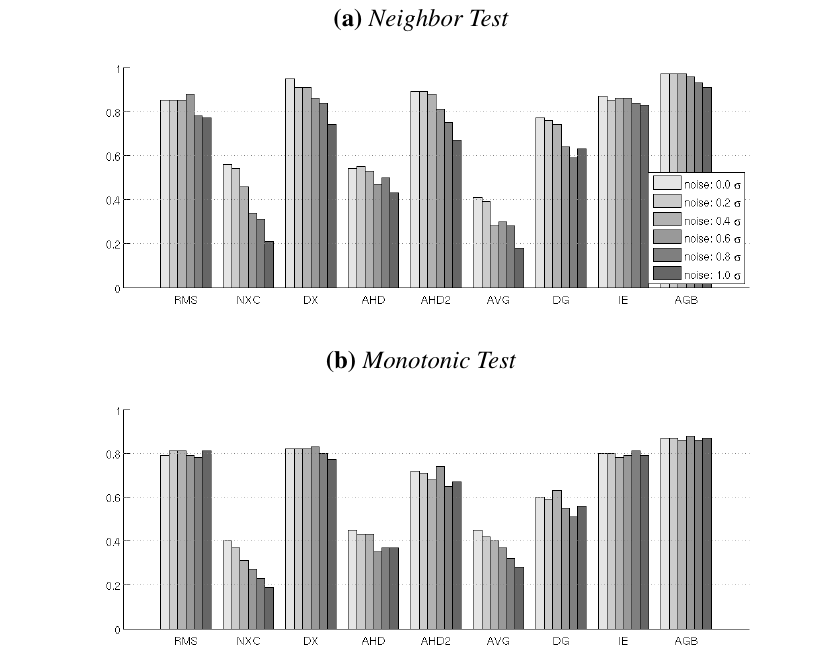
Figure 7. Fraction of Passed Neighbor Tests and Monotonic Tests for Different Levels of